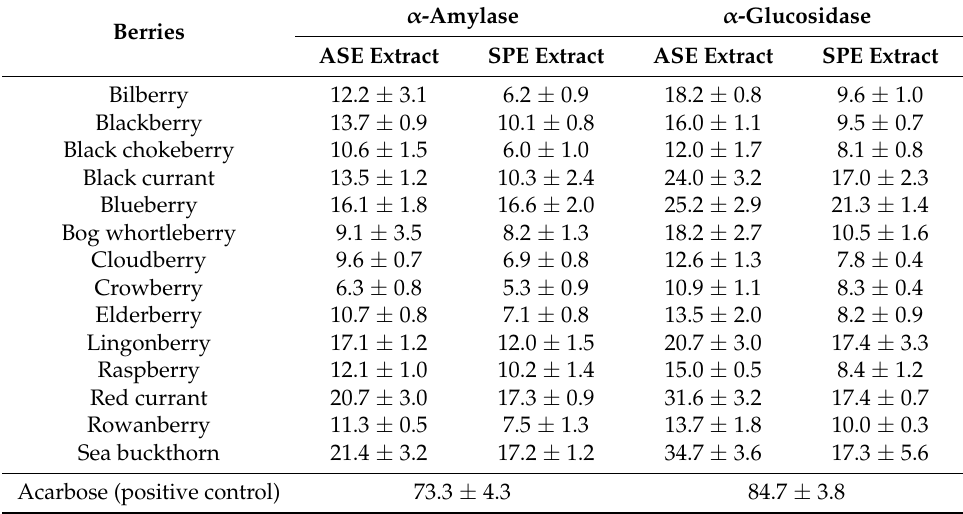
Table 3. α -Amylase and α -glucosidase inhibition of methanol ASE extracts and SPE extracts with IC 50 values ± SD (in µ